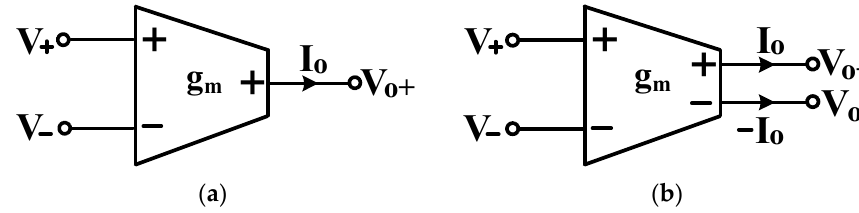
Figure 2. Symbols for operational transconductance amplifier (OTA) and dual-output operational transconductance amplifier (DO-OTA). ( a ) OTA. ( b ) DO-OTA.